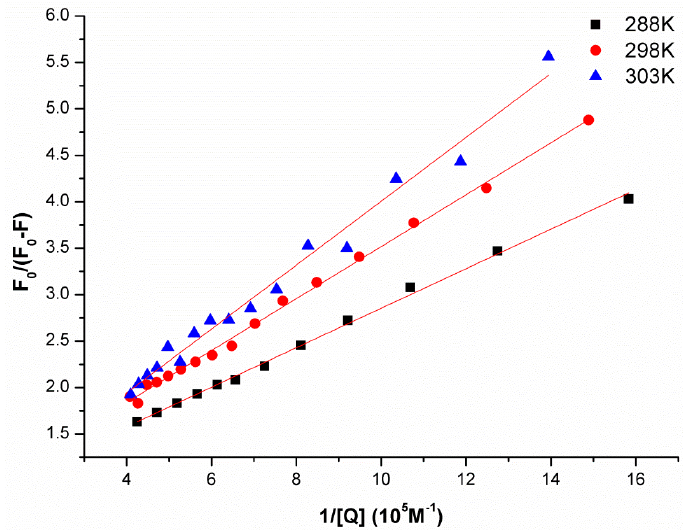
Figure 5. The modified Stern-Volmer plots used to obtain association constant of the subunit H of V-ATPase as reported method [15]. The temperature is as indicated in the figure. Table 2. Modified Stern-Volmer association constant ( Ka ) deduced from Figure 5.